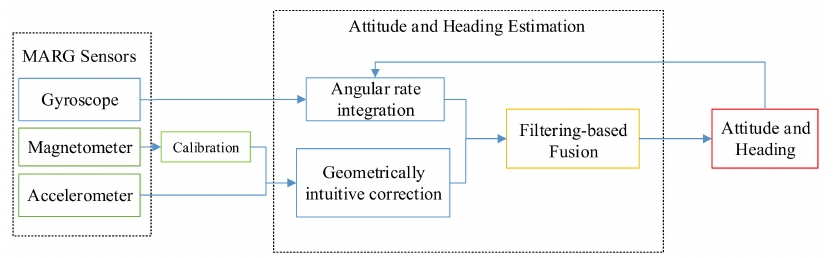
Figure 1. The frame of the fusion filter algorithm [25].